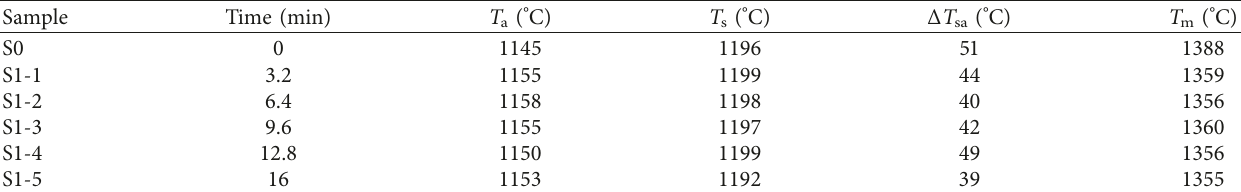
Table 7: Softening performance of the sintered ore for different oxygen enrichment times.